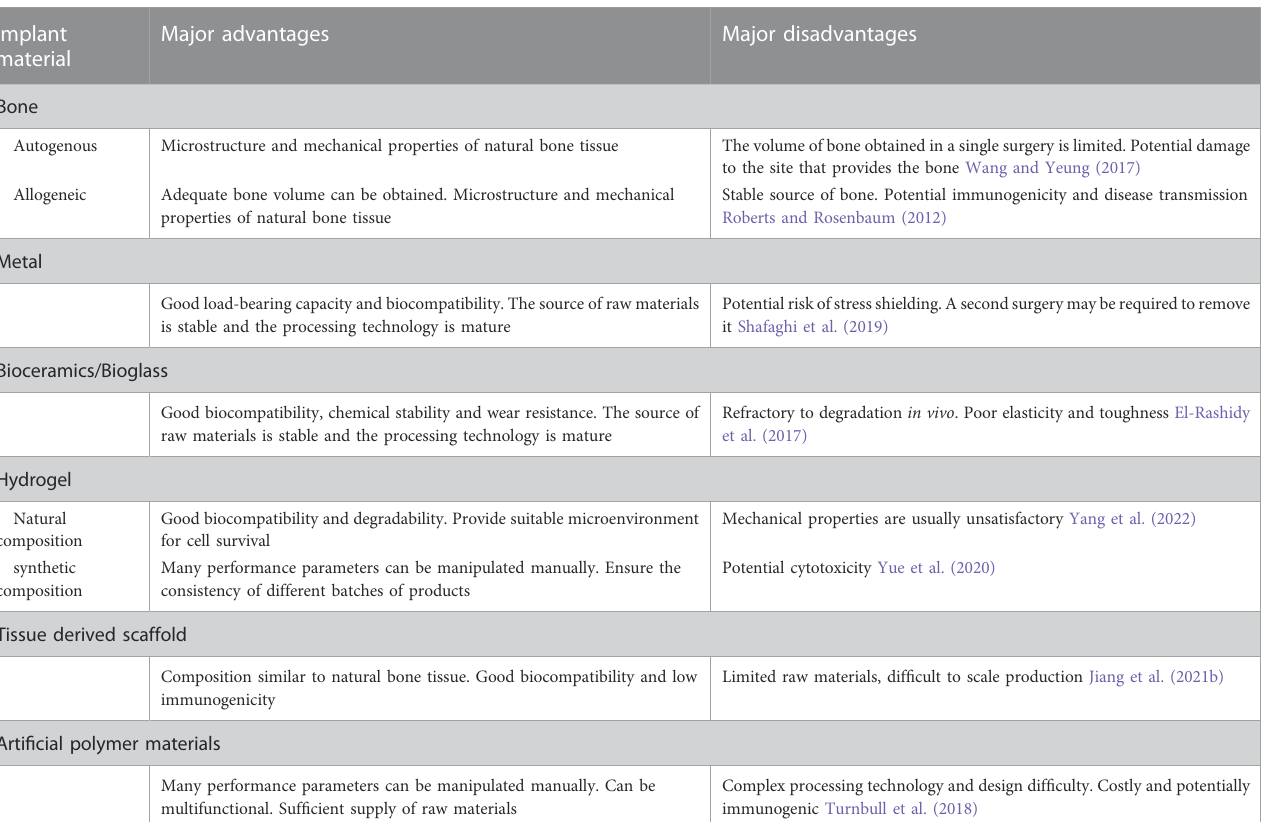
TABLE 1 Comparison of different implant materials. Implant material Bone Autogenous Microstructure and mechanical properties of natural bone tissue